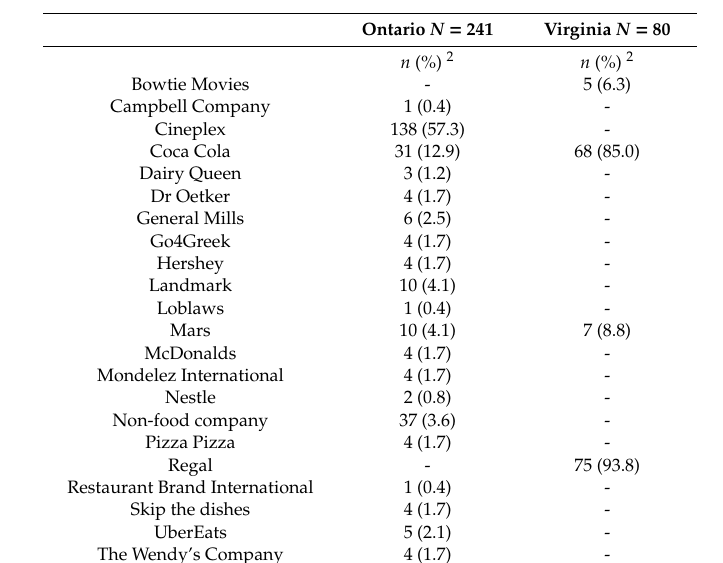
Table 4. Frequency of advertisements by food company advertised before children’s movies in